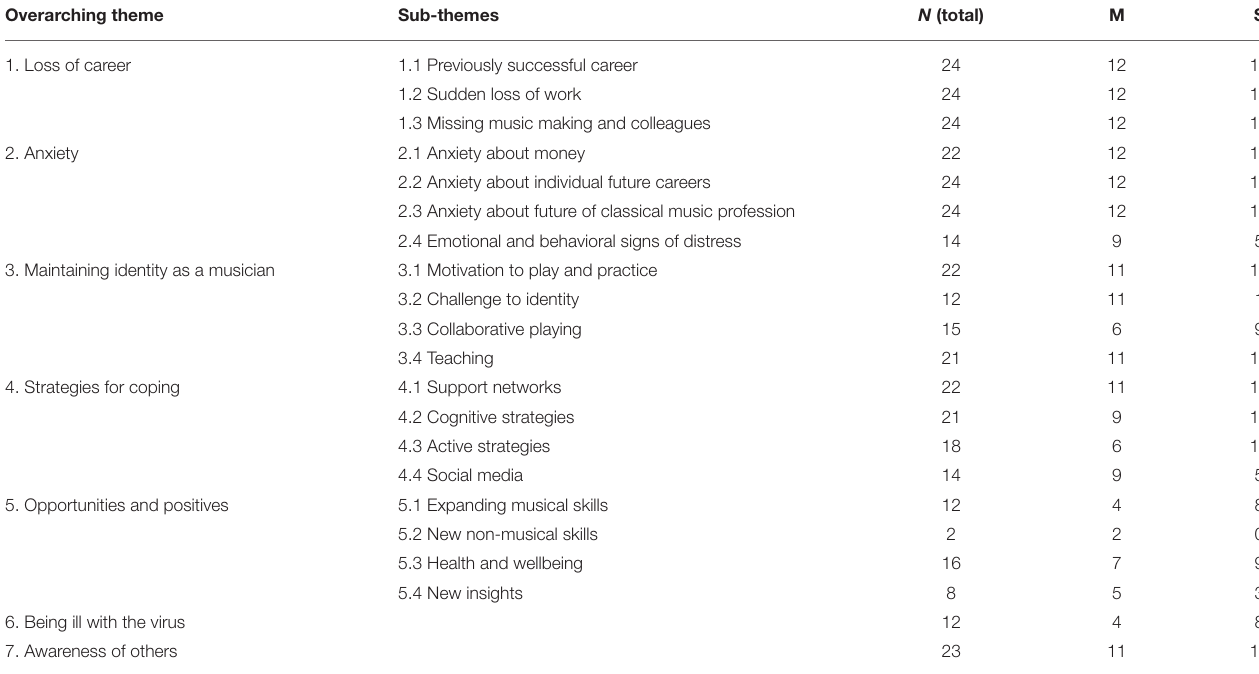
TABLE 2 | Overarching themes, sub-themes, group and number of participants for each sub-theme. Overarching